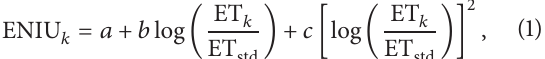
Figure 2: Detected amount of quinones obtained on different extractiontemperature.Sample:0.3 gdrycompostoffoodwasteand wood chips. SFE conditions: 25 MPa; 90% CO 2 -10% methanol; flow rate of 3 mLmin −1 ; 30 min; number of samples examined =